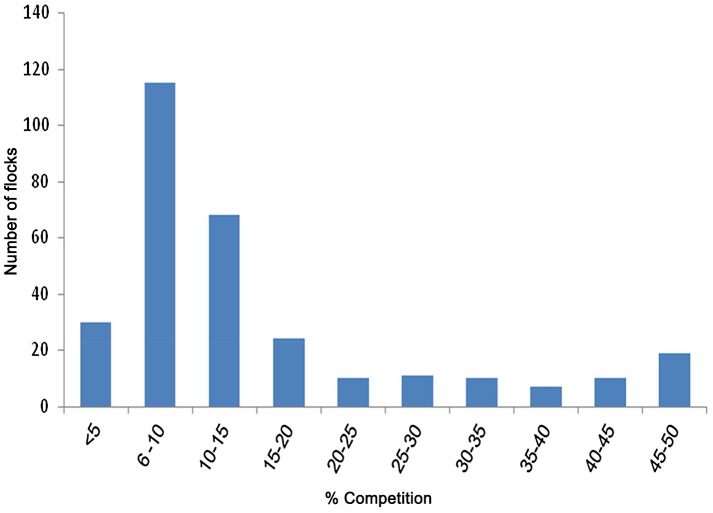
cELISA results for detection of antibodies to influenza A virus NP in commercial chicken and turkey sera.(Result was defined as positive when % of competition is ≤45%, doubtful at 45–50% and negative ≥50% competition).